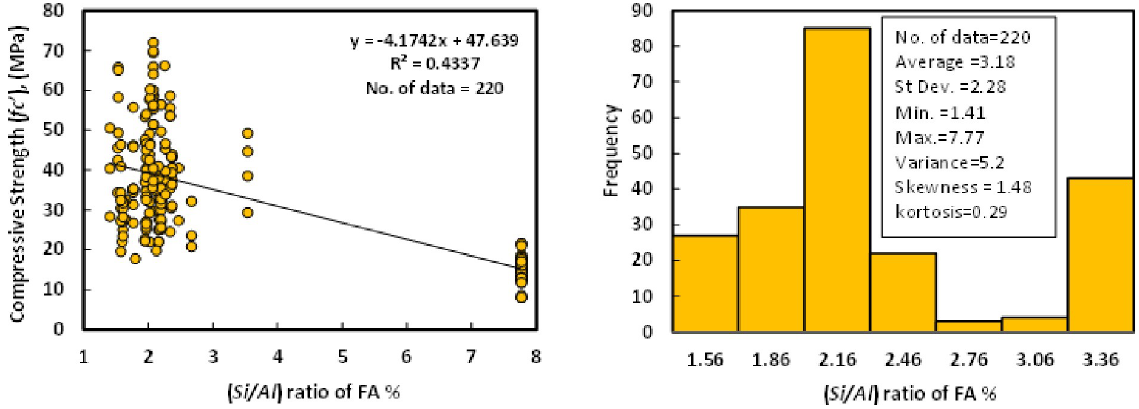
Fig 4. Relationship and a histogram of compression strength and Si/Al of fly ash.